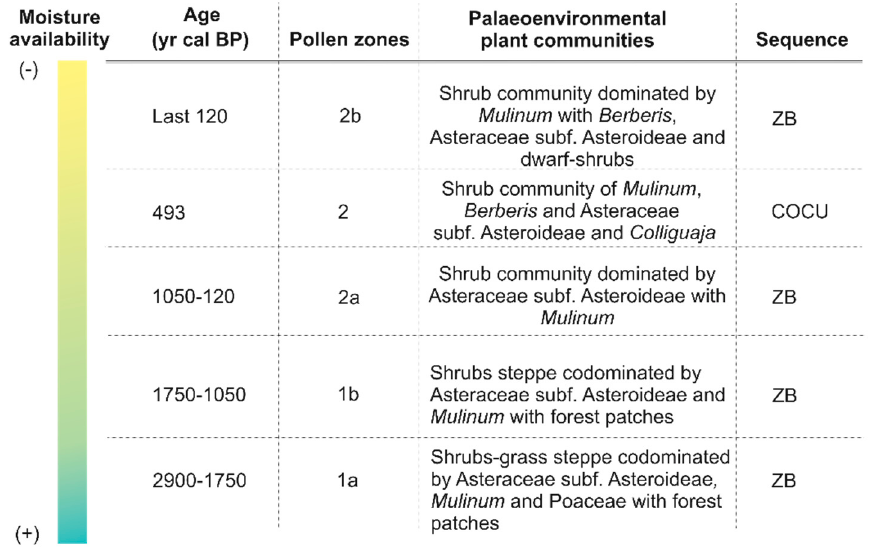
Figure 6. Reconstruction of the dynamics of the plant communities of the Pueyrredón Lake area (47° S) using the pollen information of the ZB wet meadow sequence and the COCU archaeological sequence for the last 2900 cal yr BP.